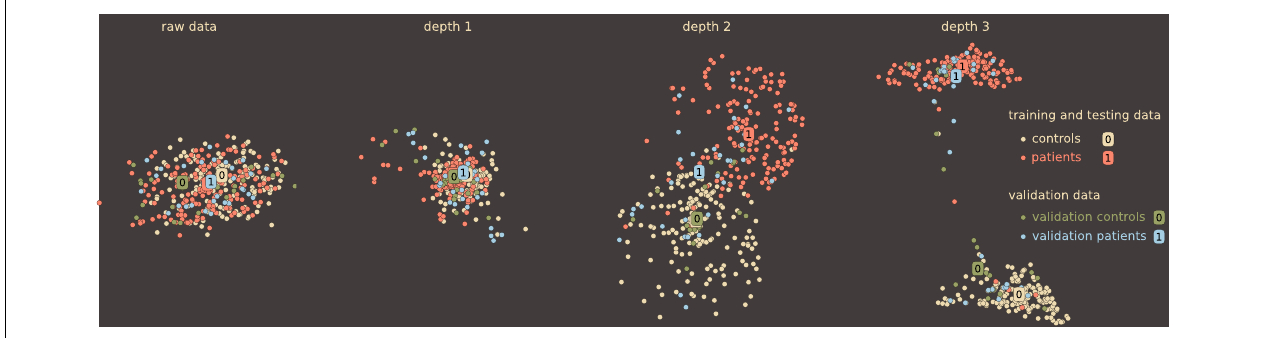
FIGURE 6 | Effect of a DBN’s depth on neighborhood relations. Each map is shown at the same iteration of the algorithm with the same k = 50. The color differentiates the classes (patients and controls) and the training (335